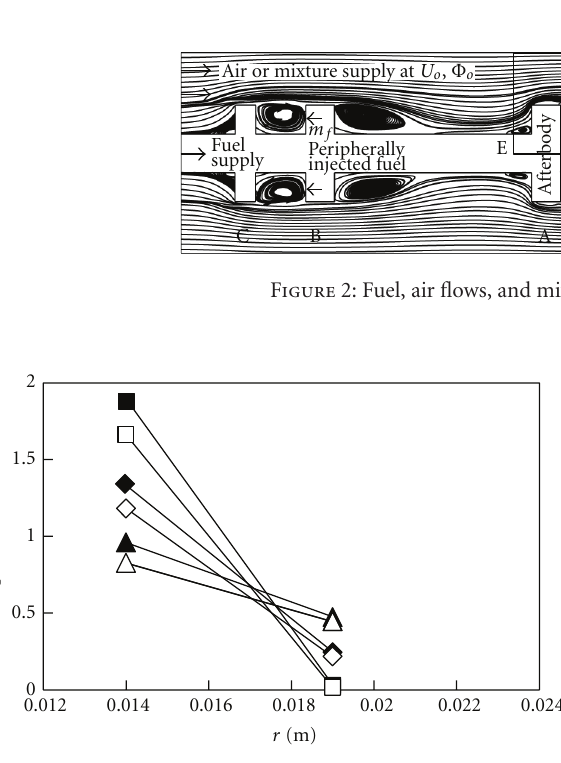
Figure 1: Combustion tunnel and premixer/burner configurations.